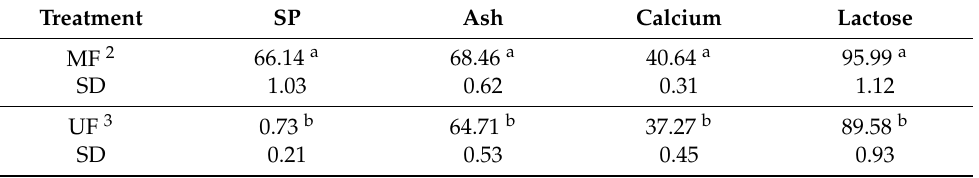
Table 5. Mean ( n = 3) percent removal of SP 1 , ash, calcium and lactose content during microfiltration and ultrafiltration of skim milk using polymeric spiral-wound membranes. Treatment SP Ash Calcium Lactose MF 2 66.14